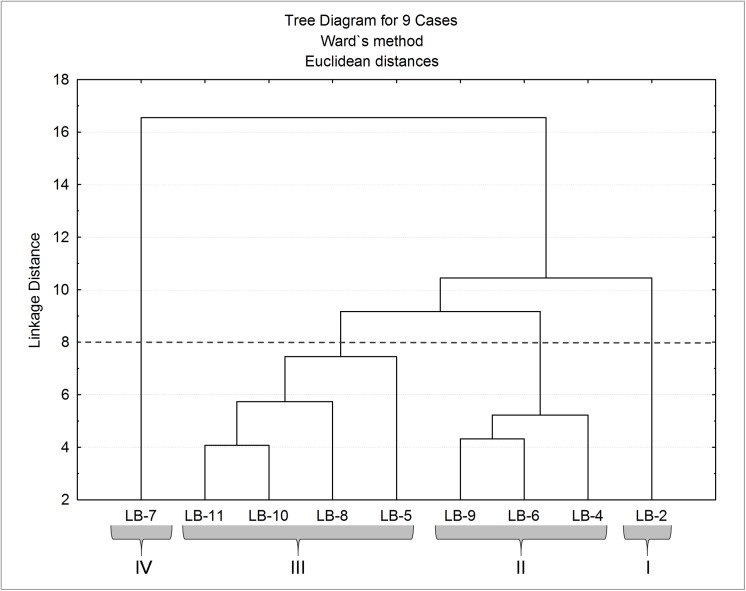
Results of Q-mode cluster analysis.